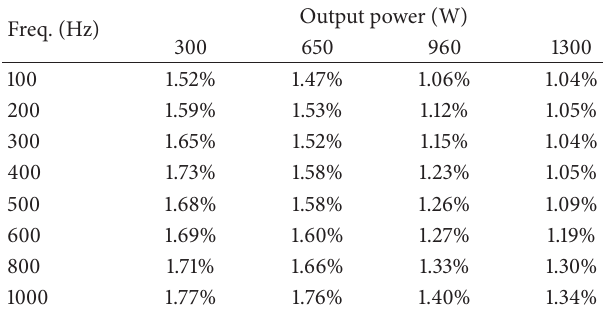
Table 1: THD values of power amplifier system.